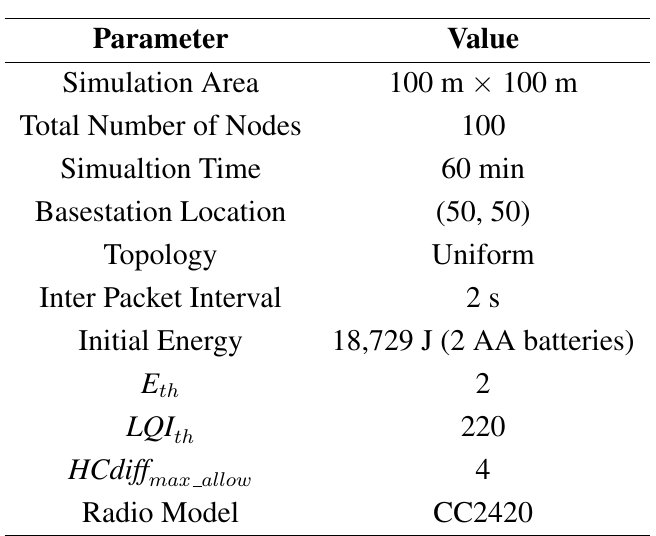
Table 1. Simulation parameters.